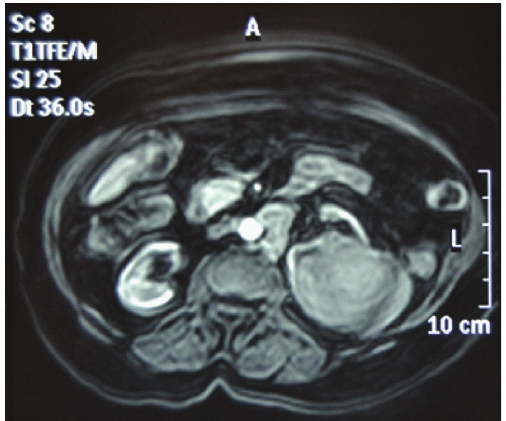
Figure 1: In the MRI, PRL is di ff erentiated from RCC based on the lower signal intensity on unenhanced T1-weighed images compared with a normal renal cortex and fewer enhancements on early gadolinium-enhanced images.